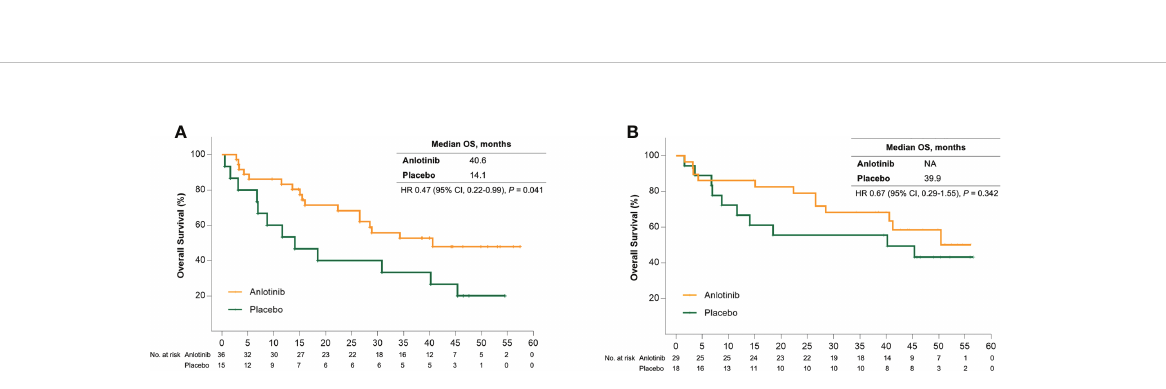
FIGURE 3 (A) Kaplan-Meier curves of overall survival for patients older than 50 years received anlotinib (orange) or placebo (green) after extension of follow up. (B) Kaplan-Meier curves of overall survival for patients with bone metastases received anlotinib (orange) or placebo (green) after extension of follow